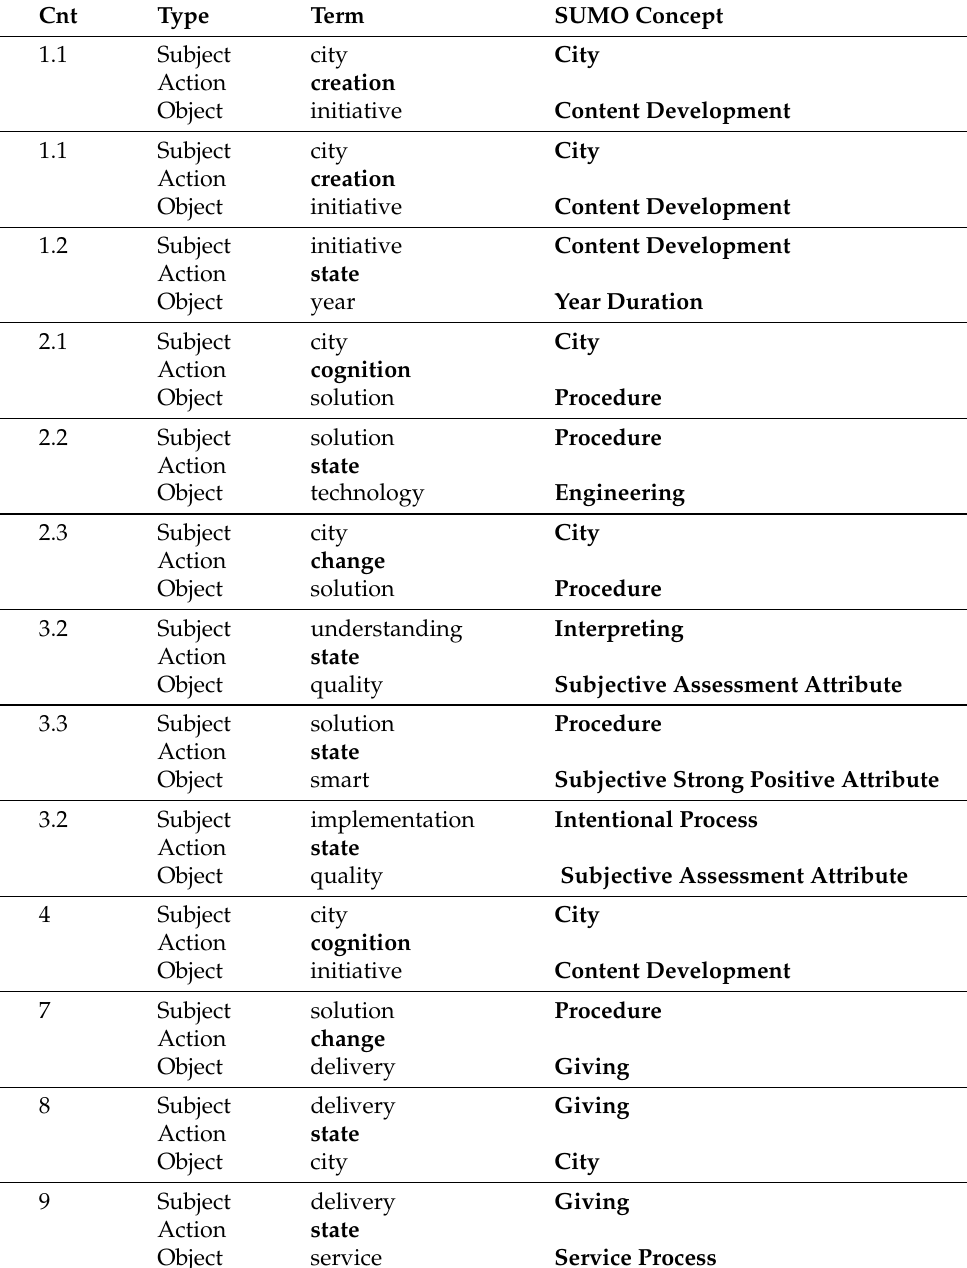
Table 3. Example triplets generated after applying the preprocessing techniques explained in Section